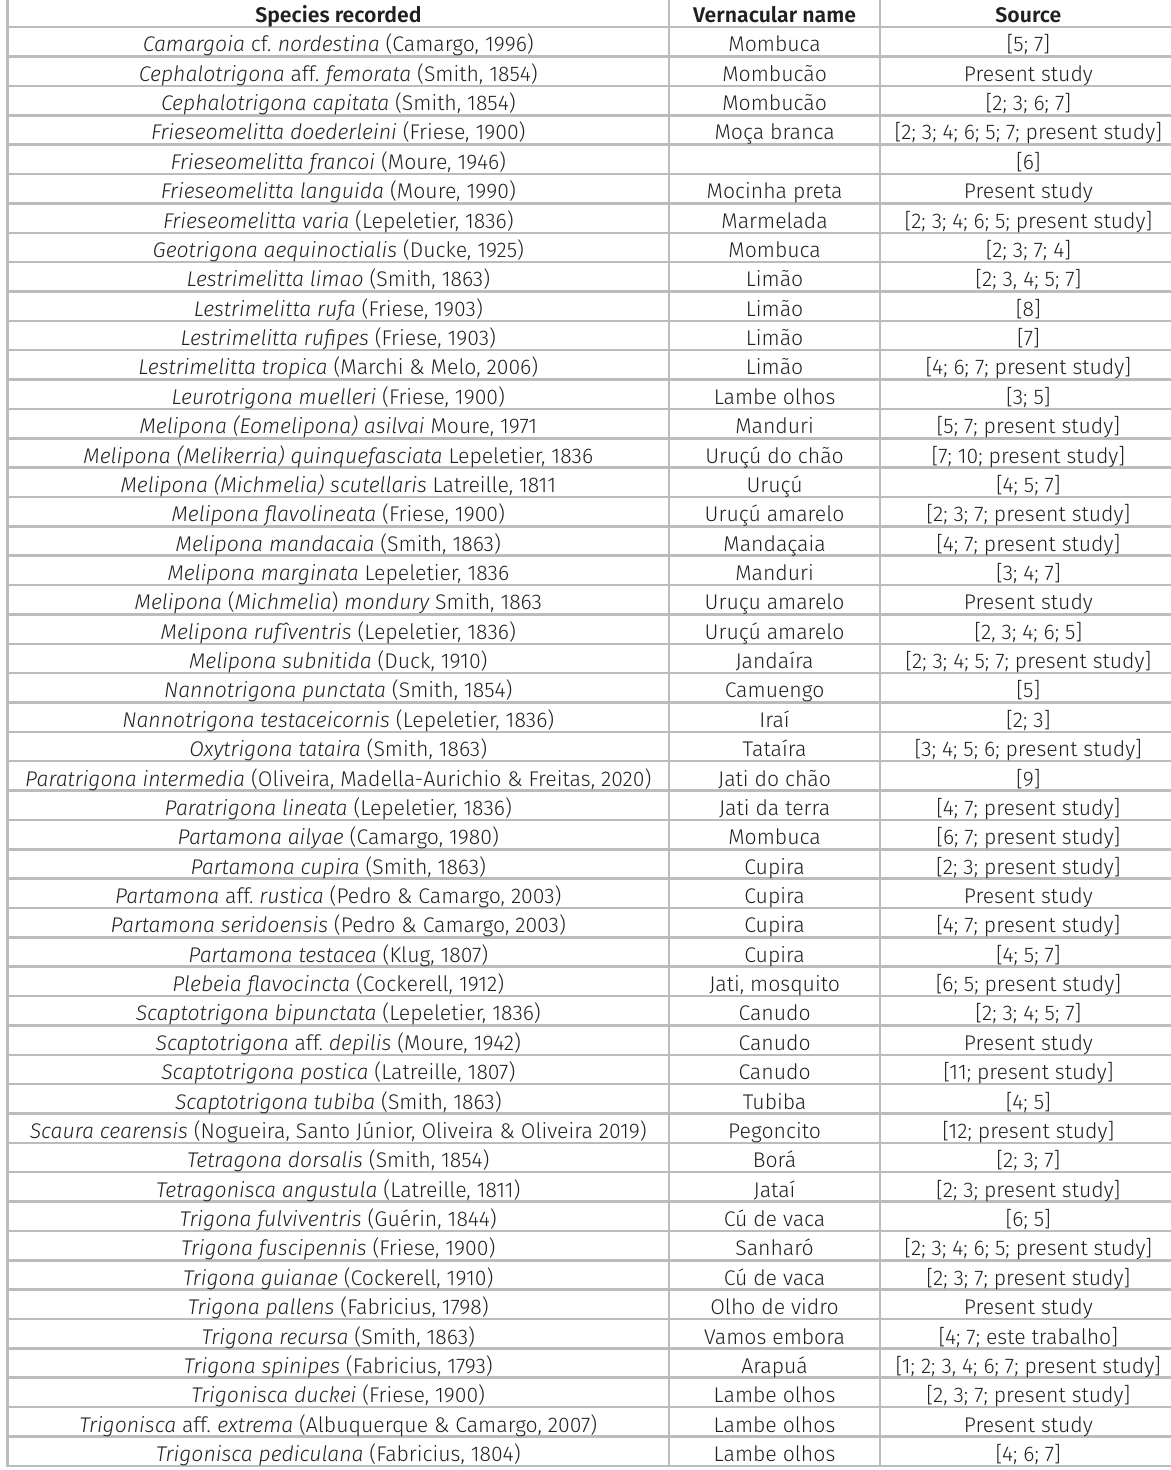
Table IV. List of meliponines species with occurrence recorded in the State of Ceará according to the literature. [1] Ducke 1907; [2] Ducke 1908; [3] Ducke 1910; [4] Gonçalves 1973; [5] Westerkamp et al. 2007; [6] Lima-Verde 2011; [7] Pedro 2014; [8] Mascena et al. 2017; [9] Oliveira et al. 2020; [10] Lima-Verde & Freitas 2002; [11] Camargo & Pedro 2013; [12] Nogueira et al. 2019a; [present